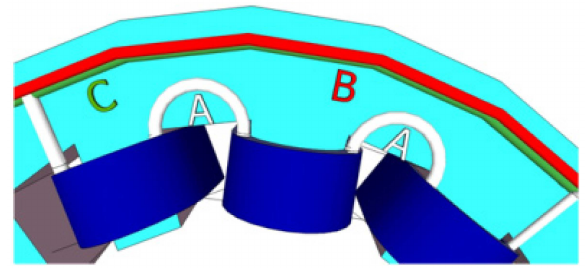
Figure 7. Three coils (in blue) are connected in series. The connections (in white, A ) show that they take some space in the area used to place circles (in red, B and in green, C ). There are four circles, two more than in the figure, one for each phase and one for the neutral. In this figure the cross-sections are small in order to clearly show all of the